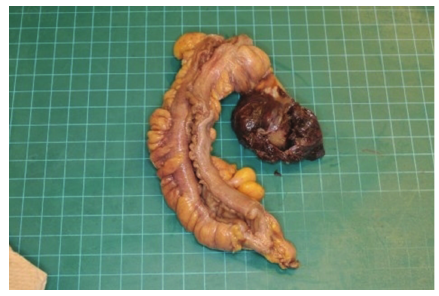
Figure 2: Macroscopic appearance of the tumor. The mass is attached to the mesorectum. (The ovaries, not shown, were grossly and microscopically